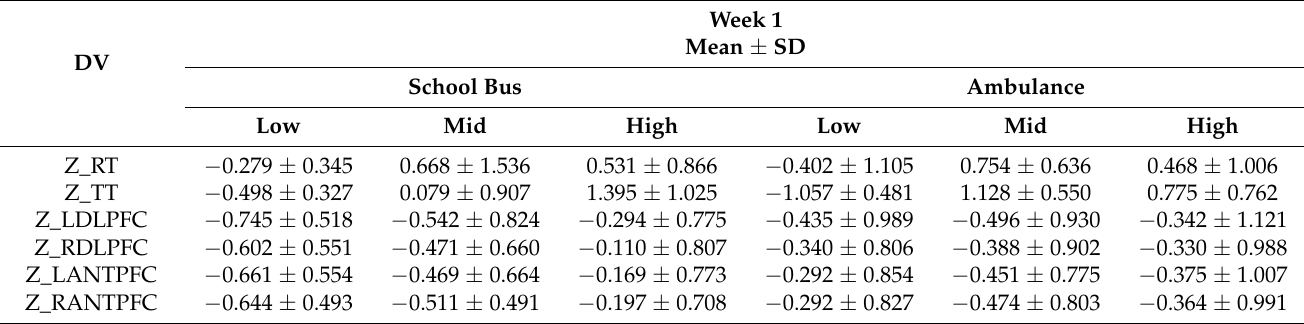
Table A2. Week 1 standardized Z scores for School Bus and Ambulance problem scenarios.